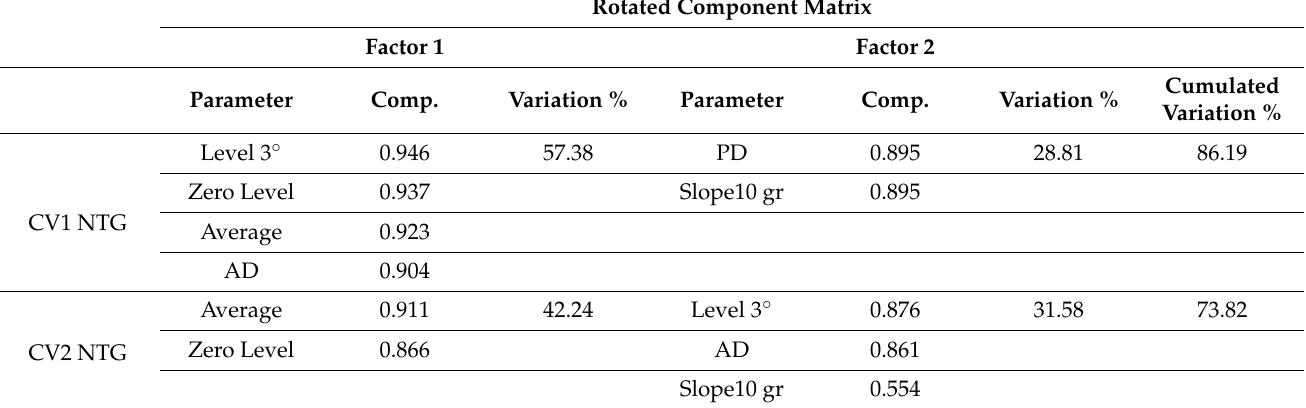
Table 13. Comparative distribution of the common factors of the “Visual field” indicators of patients with NTG at the first and second consultation (C1 and